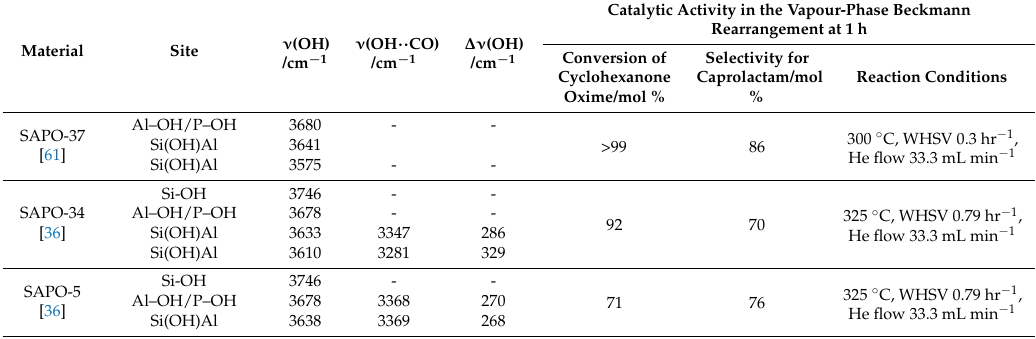
Table 2. Assignment of the FTIR hydroxyl stretching modes ( ν (OH)) of SAPO materials and their shift ( ∆ ν (OH)) following CO adsorption. The activity of the SAPO catalysts in the vapour-phase Beckmann rearrangement is also